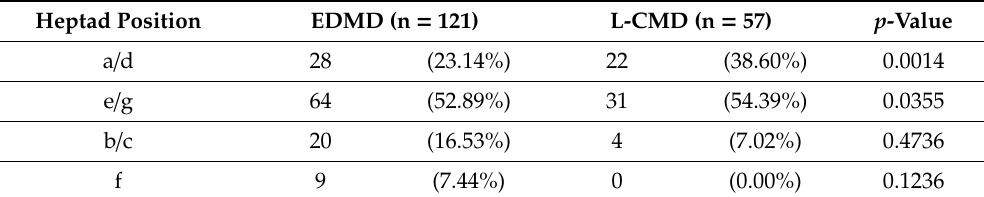
Table 5. Heptad position a ff ected among missense mutations found in coil domains of EDMD and L-CMD index